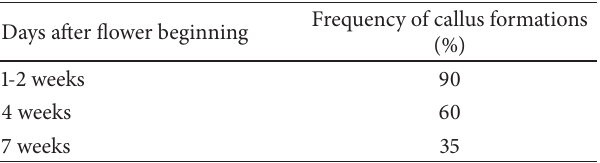
Table 2: Frequency of callus formation of flower buds collected in different time after bud